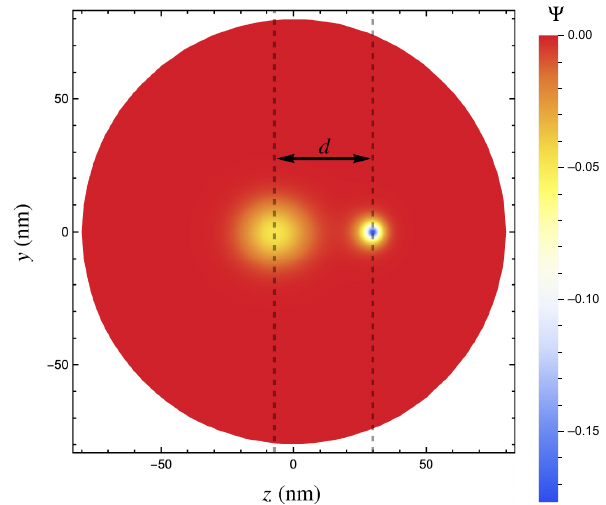
FIG. 9. Ground-state wave function in the donor plane for E ext = E 0 ext